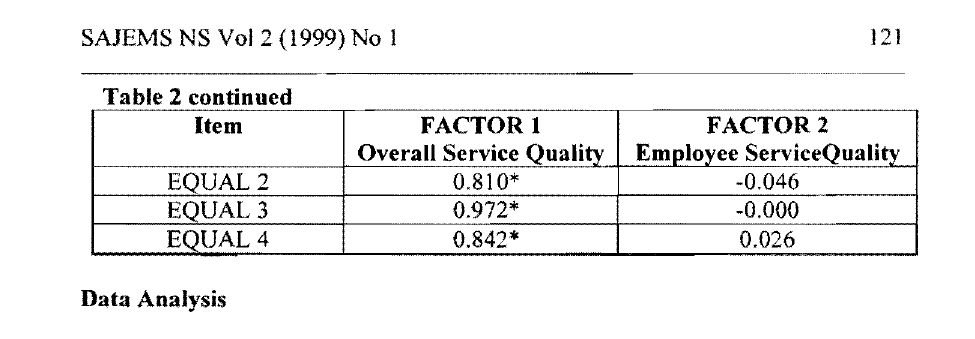
Figure 1: Hypothesized